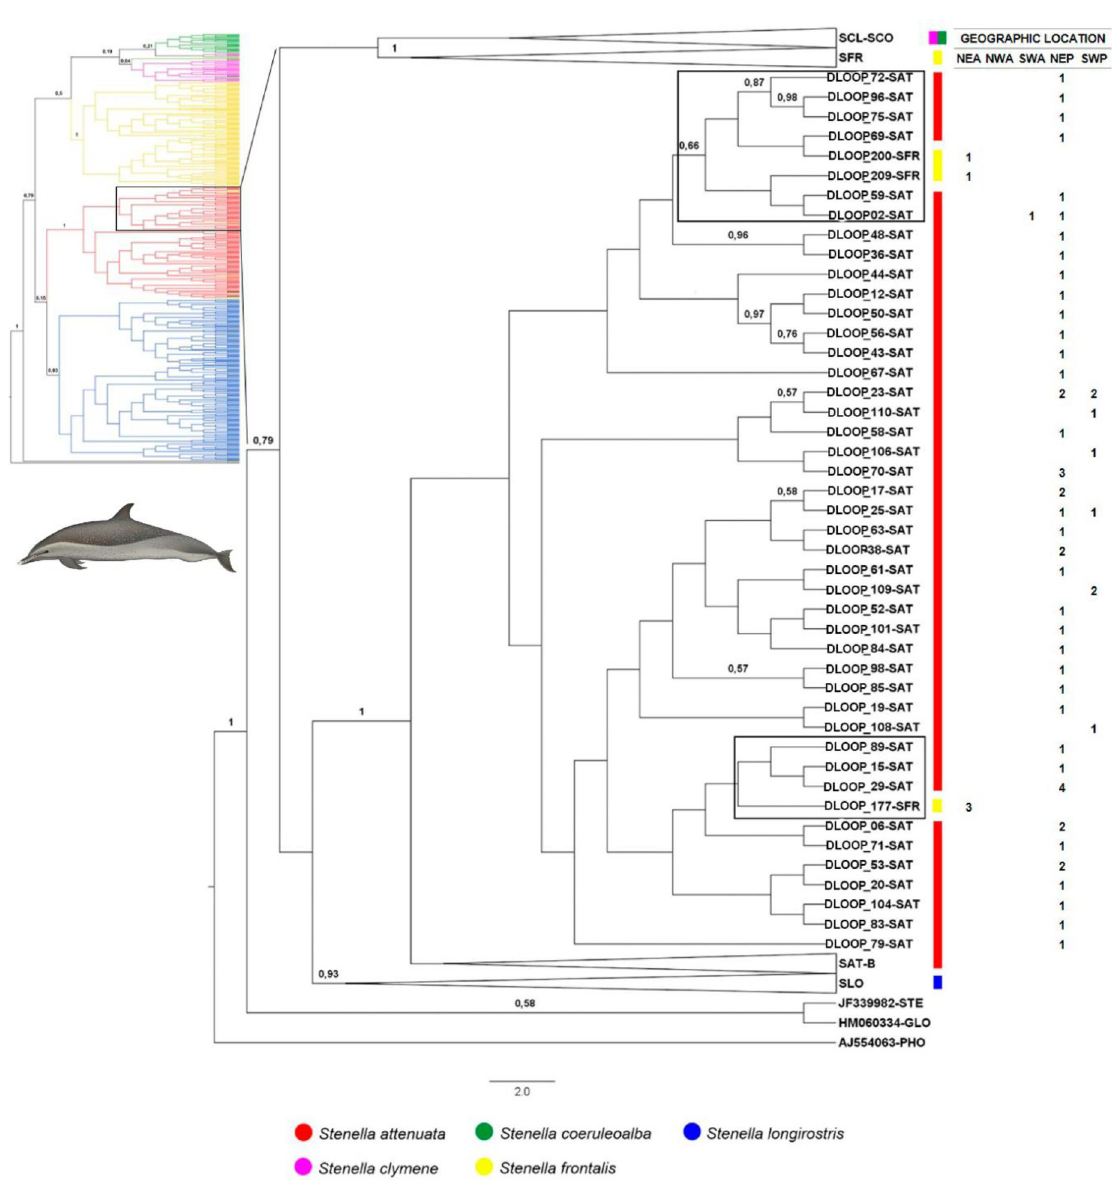
Fig 6. Bayesian cladogram generated by Beast from the Dloop sequences (331bp) highlighting the first clade of Stenella attenuata for ocean basin comparisons. Posterior probability values greater than 0.5 are presented above nodes. Black boxes indicate misplaced haplotypes. Table at right displays the ocean basin location of each haplotype and the number of specimens: NEA (Northeast Atlantic Ocean), NWA (Northwest Atlantic Ocean), SWA (Southwest Atlantic Ocean), NEP (Northeast Pacific Ocean), SWP (Southwest Pacific Ocean). The numbers in the columns represent the number of specimens for each haplotype. Dolphins images have been extracted from the website http://cis.whoi.edu/science/B/whalesounds/index.cf.